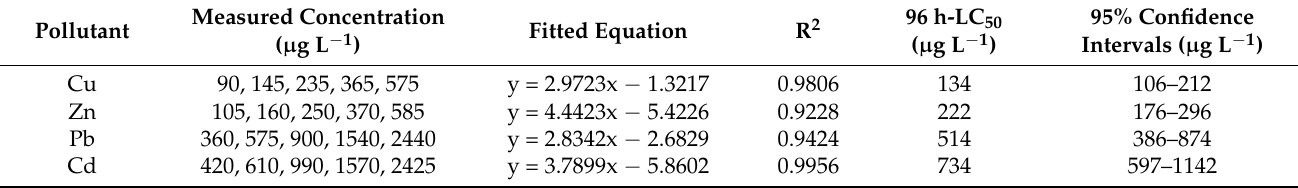
Table 1. The measured concentrations and 96 h-LC 50 values of four heavy